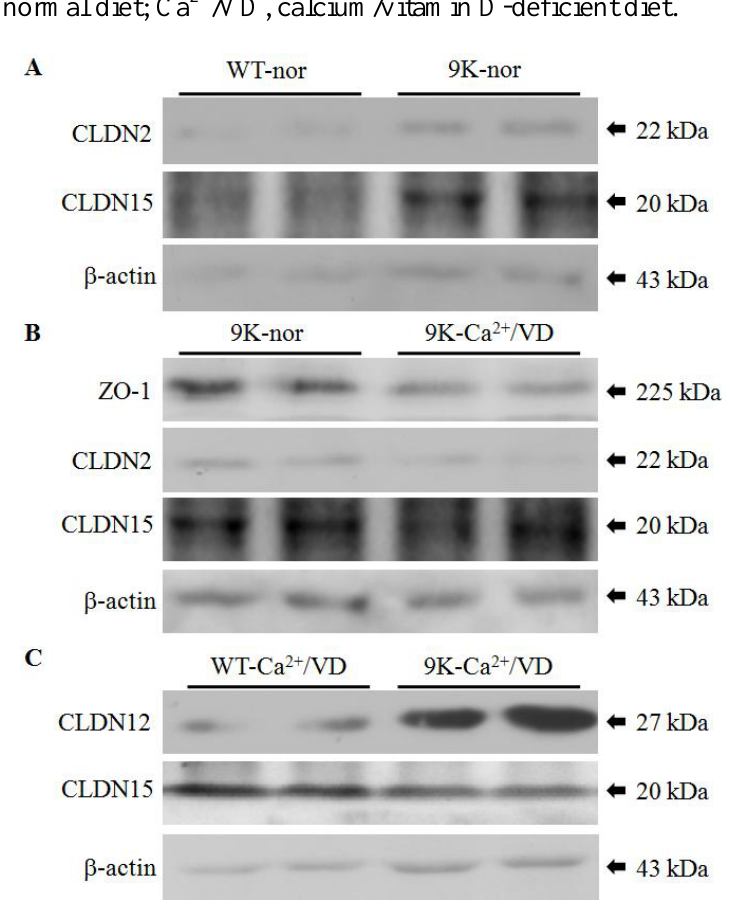
Figure 2. Regulation of tight junction protein expression in the duodenum. ZO-1, CLDN2, 12 and 15 protein expression was measured by Western blotting. The levels of CLDN2, and CLDN15 proteins in WT and CaBP-9k KO mice were compared ( A ); ZO-1, CLDN2 and CLDN15 protein expression levels were compared between normal and calcium/vitamin D-deficient CaBP-9k KO mice ( B ); In calcium- and vitamin D-deficient WT and CaBP-9k KO mice, CLDN12 and CLDN15 protein expression levels were compared ( C ); β -actin was used as an internal control for each experiment. 9k, CaBP-9k KO mice; nor, normal diet; Ca 2+ /VD, calcium/vitamin D-deficient